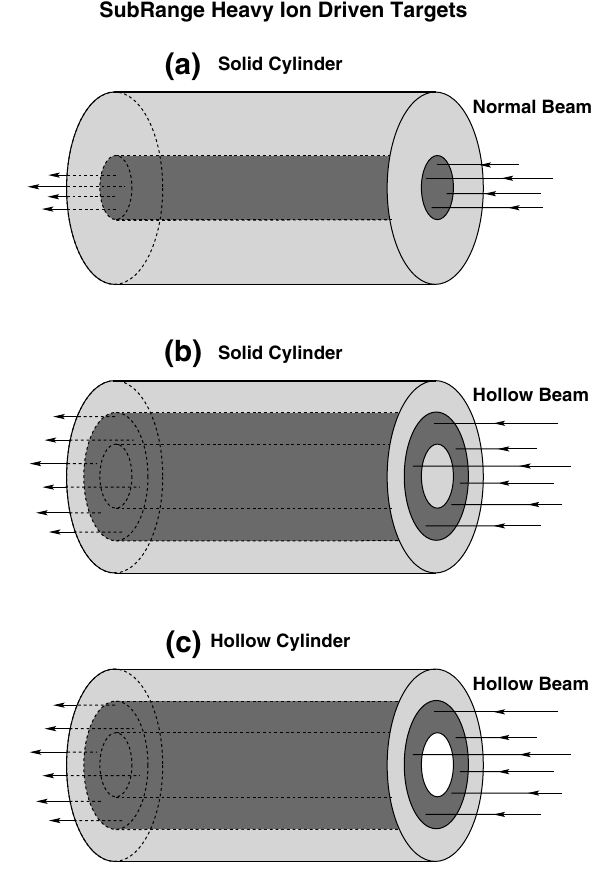
FIG. 4. Beam-target geometry for three proposed experi- ments: (a) a solid cylinder irradiated with a beam having a circular focal spot, (b) a solid cylinder irradiated with a hollow beam, and (c) a hollow cylinder irradiated with a hollow